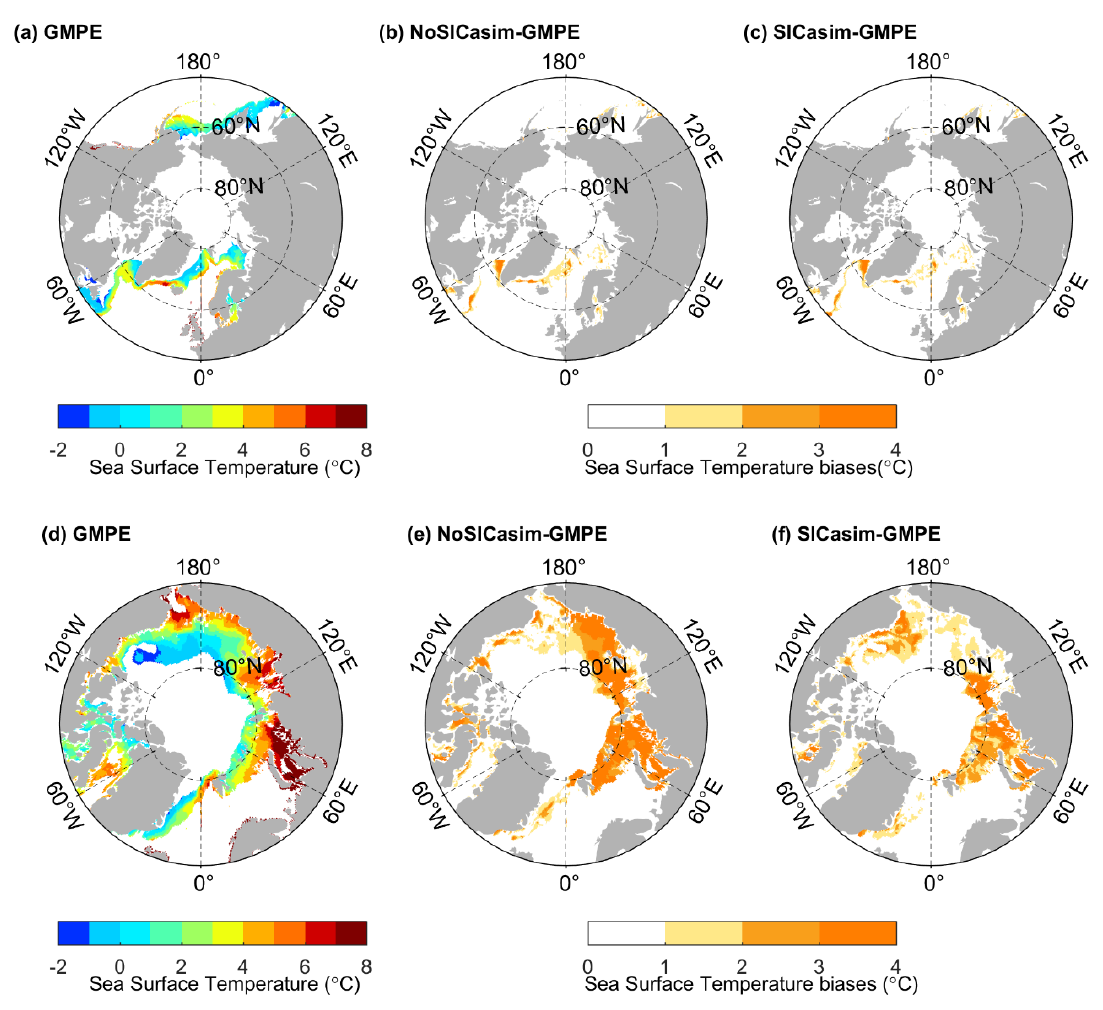
Figure 6. Spatial distributions of SST (unit: °C) based on the GMPE SST Observation ( a , d ), the absolute biases of NoSICasim ( b , e ), and SICasim ( c , f ). The results for March are shown in ( a – c ), while for September they are shown in ( d – f ). Areas either with sea ice concentrations above 15% in the NSIDC observation or ice-free regions in NoSICasim are represented as white.